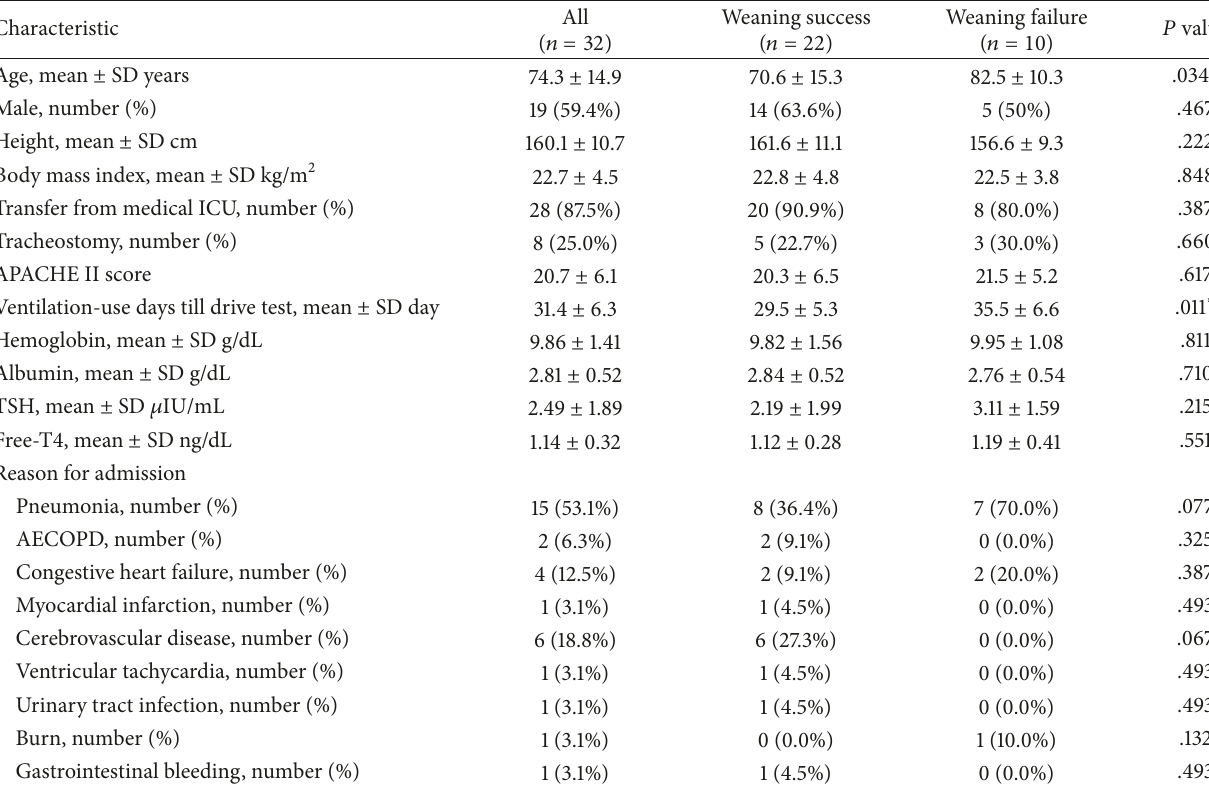
Table 1: Clinical characteristics of enrolled